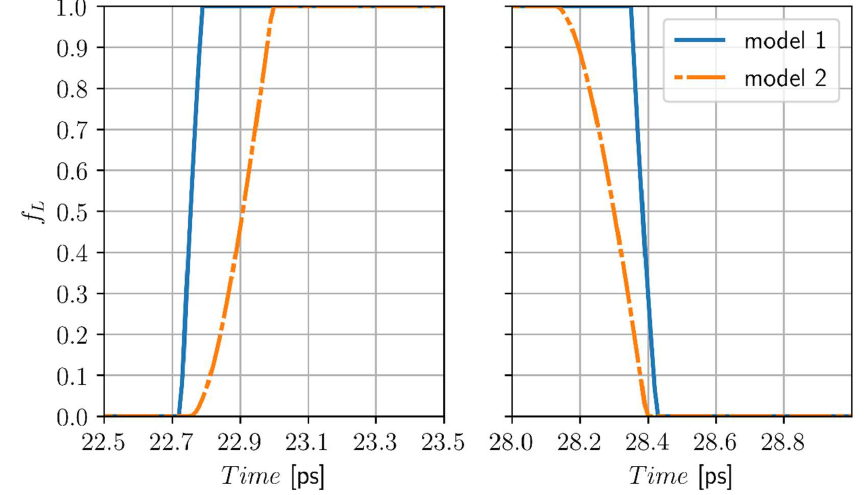
Figure 3. Changes of the volumetric liquid state at the point P 1 (0, 0), model 1—artificial mushy zone (∆ T =3 K), model 2—melting at the constant temperature, chromium, I 0 = 1.6 × 10 4 J/m 2 , t p = 10 ps.